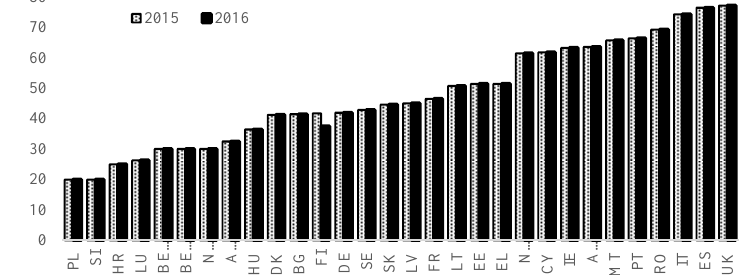
Figure 1. Scope Index of Fiscal Institutions (SIFI) in 2015 and